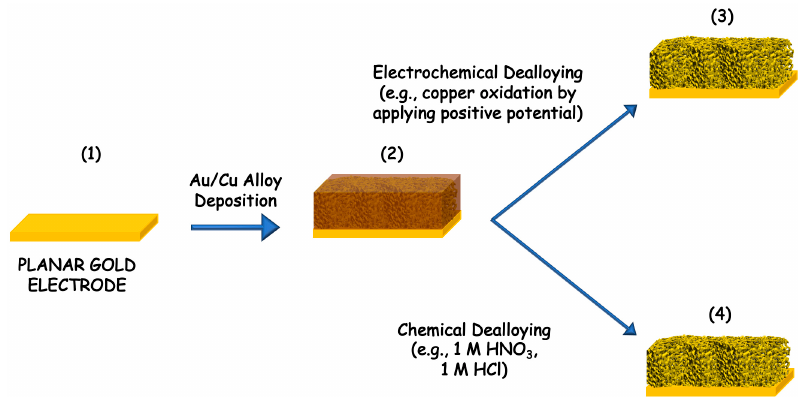
Figure 2. Scheme of gold dealloying process: ( 1 ) cleaning of planar gold electrode, ( 2 ) sputtering of gold / copper (Au / Cu) alloy that can be dealloyed either by ( 3 ) electrochemical dissolution of copper through its oxidation at positive potential or by ( 4 ) chemical dissolution performed in strong concentrated acids or bases solutions.